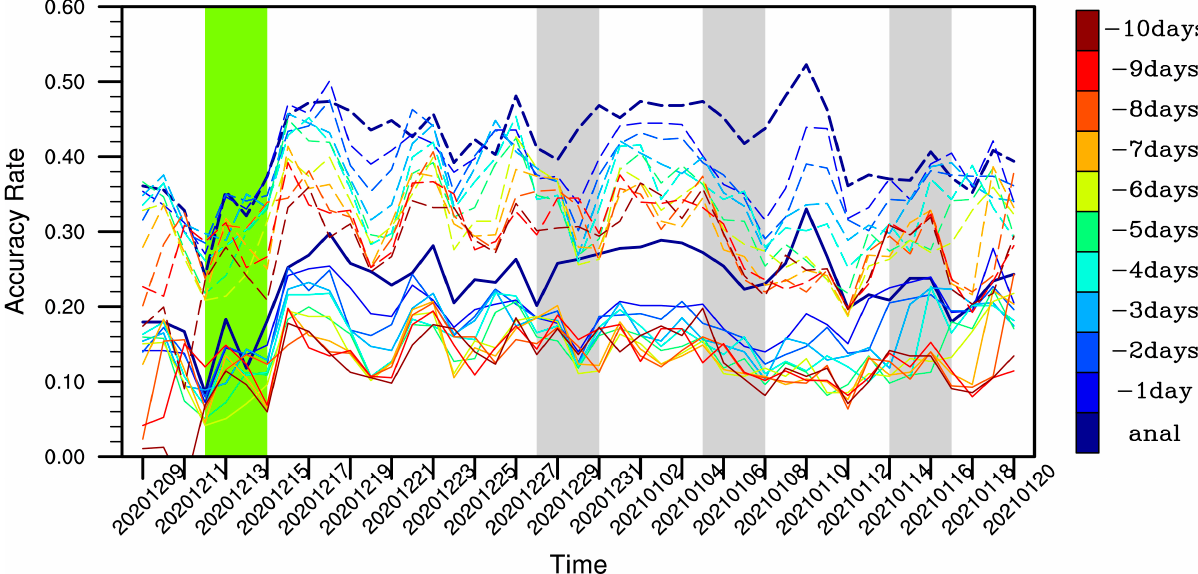
Figure 8. The accuracy rate of the CMA-GEPS forecast of the national 2-m temperature during the 2020/2021 cold wave. The do tt ed line represents the absolute error of less than or equal to 2 °C, while the solid line represents the absolute error of less than or equal to 1 °C. The green fi ll in the fi gure represents the “1212” event. The gray fi lls in the fi gure represent the “1228”, “0105”, and “0114” events.